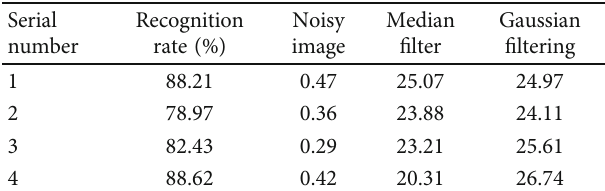
Figure 4: Numerical smoothing curve of oil painting texture noise frequency. Table 2: Gray-scale attributes of oil painting